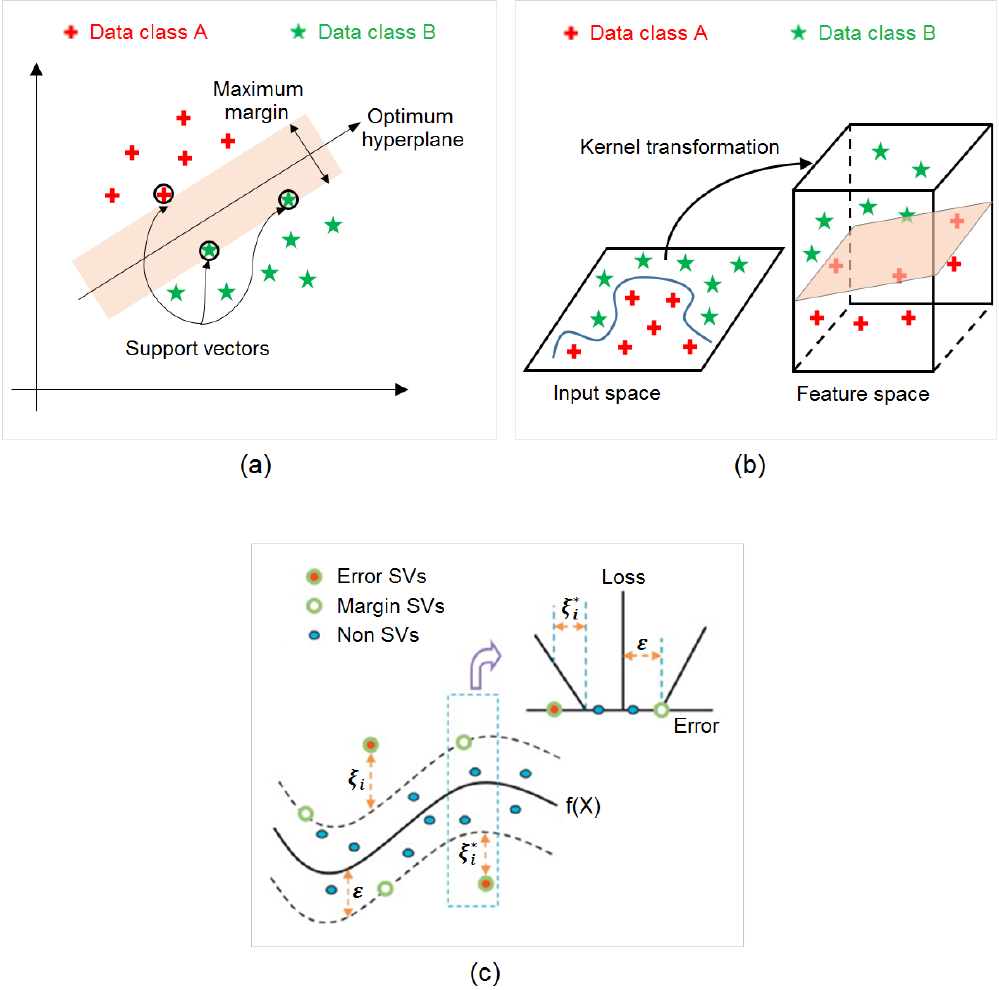
Figure 3. Concepts of the support vector classification (SVC) algorithm for ( a ) linear separable cases, ( b ) non-linear separable cases with kernel transformation, and ( c ) non-linear SVR (adapted from Raghavendra and Deka [36]).